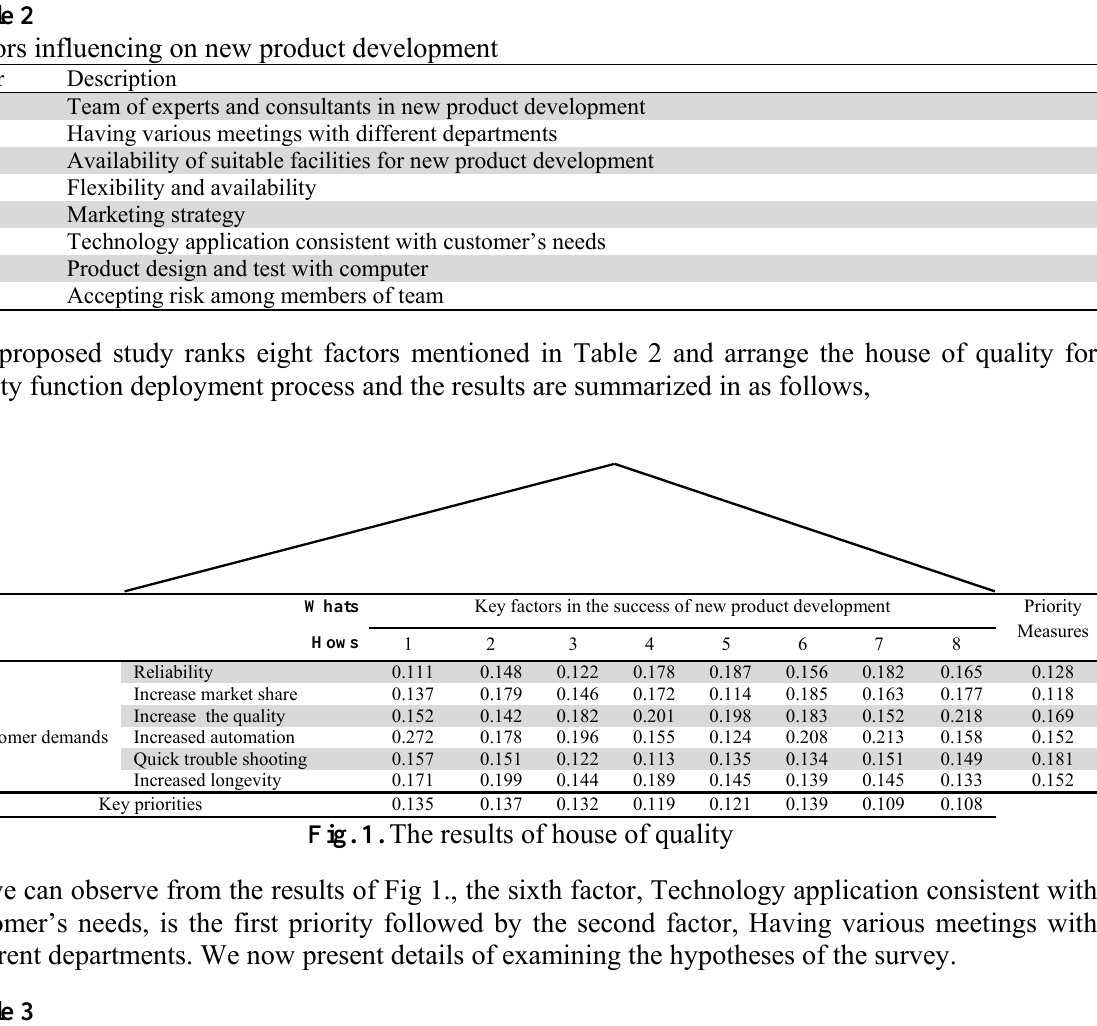
The results of testing various hypotheses